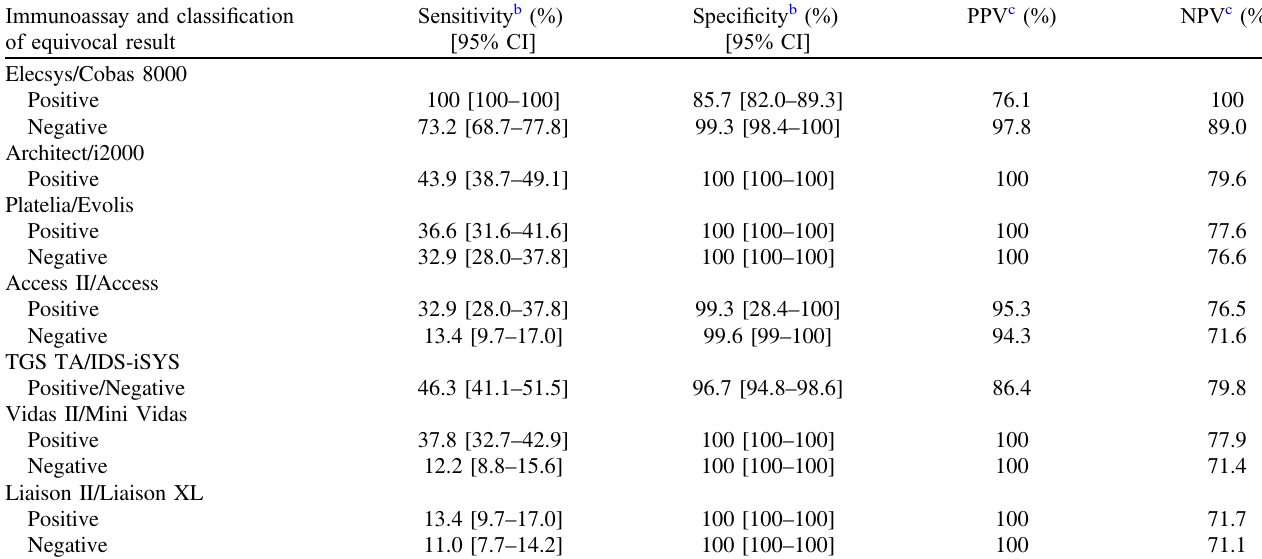
Table 3. Relative sensitivity, speci fi city, PPV, and NPV by testing 82 positive and 272 negative samples for anti-toxoplasma IgG. a